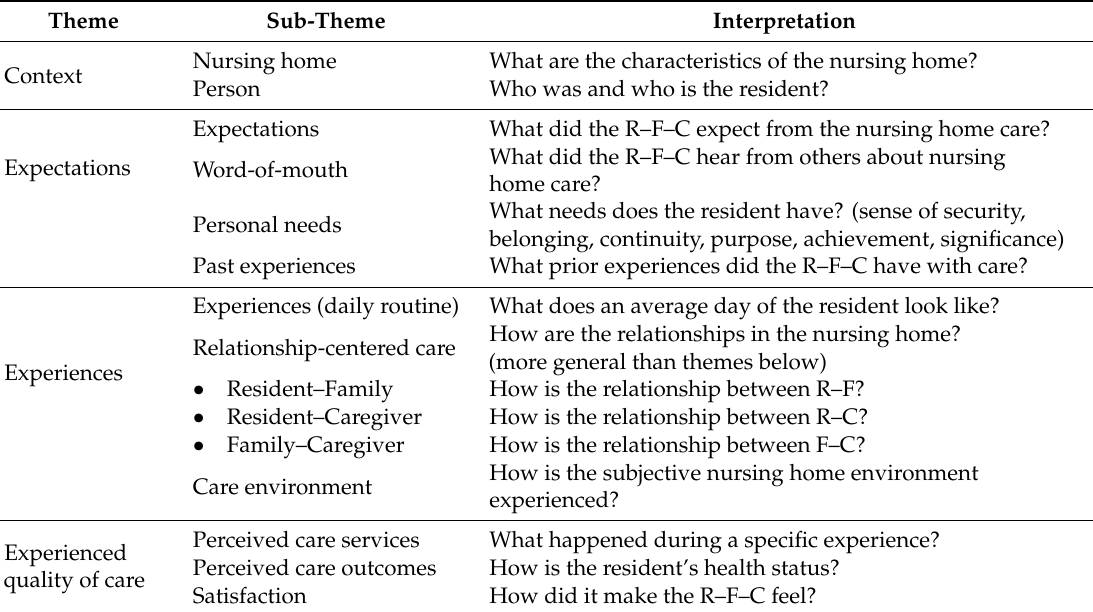
Table 2. Code tree Individually Experienced Quality of Long-Term Care